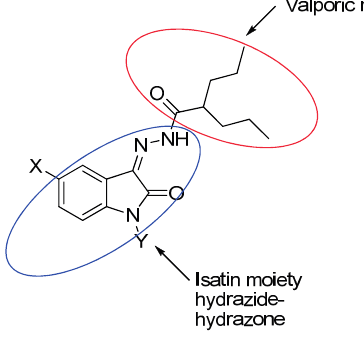
Figure 1. Structure of the target